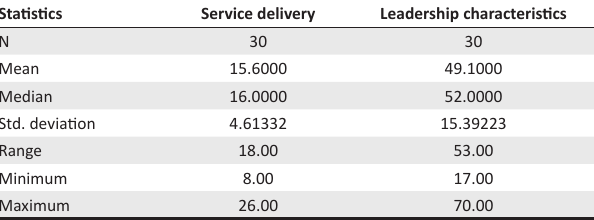
TABLE 3: Rating of service delivery and leadership characteristics.